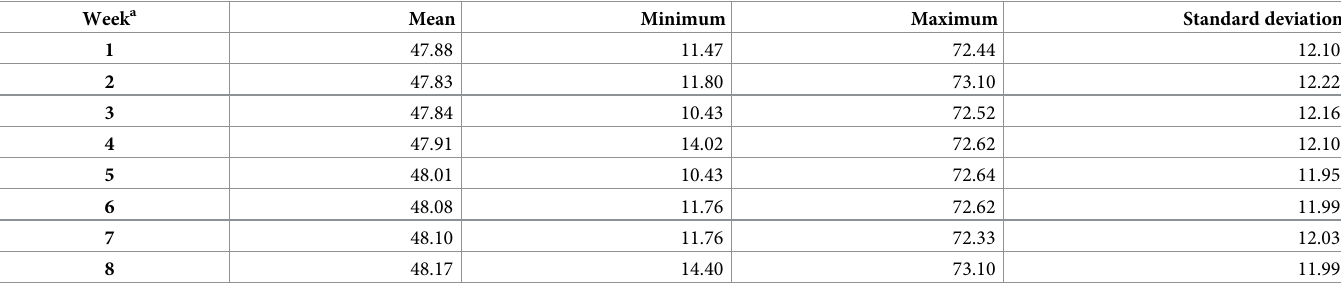
Table 2. Descriptive statistics of the weekly temperature humidity index before